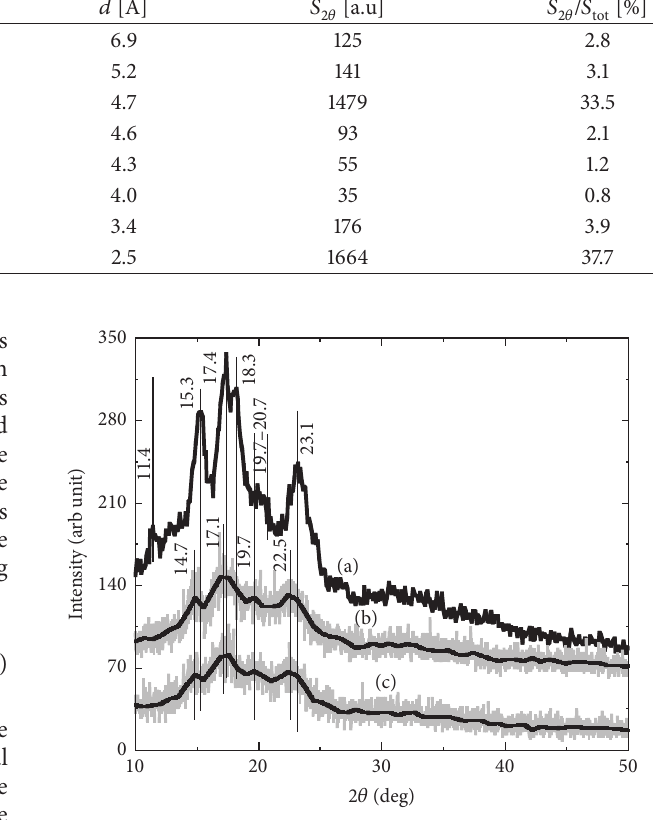
Figure 2: The diffractogram of the starch before heating (a), after 2 hours of heating at 80 ∘ C (b), and after 2 hours of heating at 140 ∘ C (c). The shadow lines represent the experimental data as recorded and the solid lines represent the data after